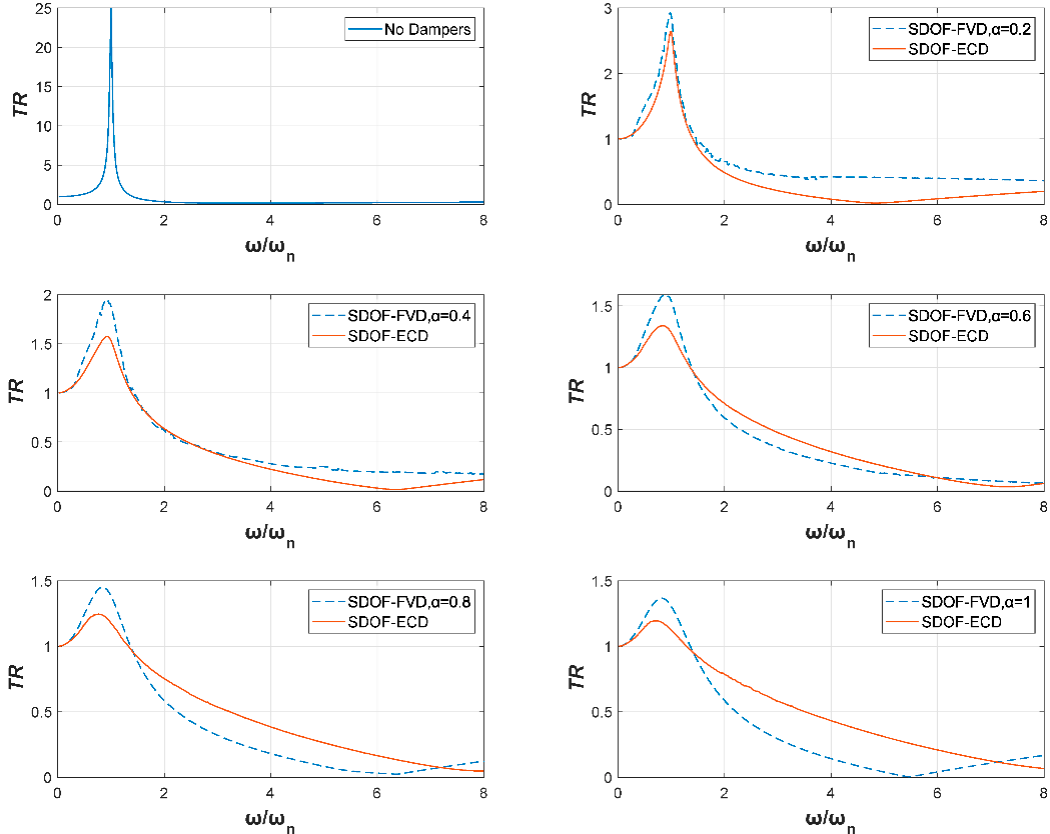
Figure 6. Comparison of acceleration transmissibilities for SDOF-ECDs and